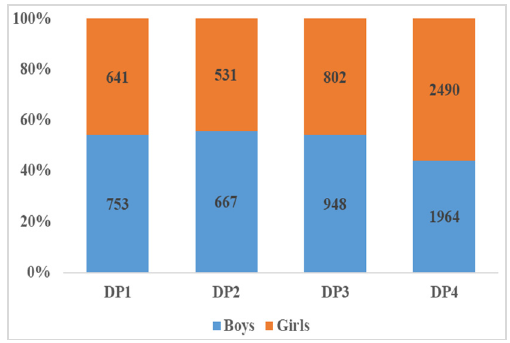
Figure 5. Number and proportion of boys and girls in each dietary pattern.